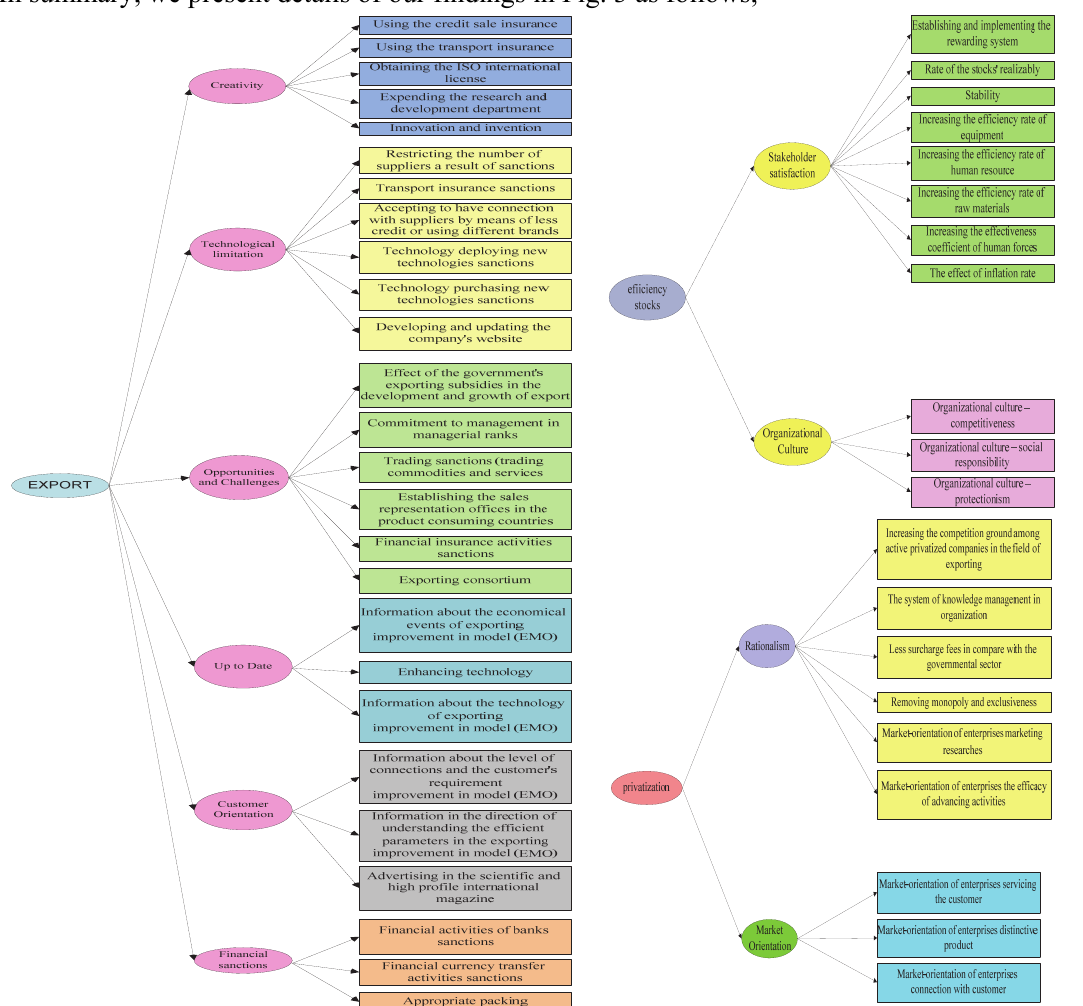
Fig. 3. The summary of factors influencing on exports, firm performance and privatization In terms of the factors influencing on export activities, creativity is the first factor. Table 8 shows the ranking of the factors on